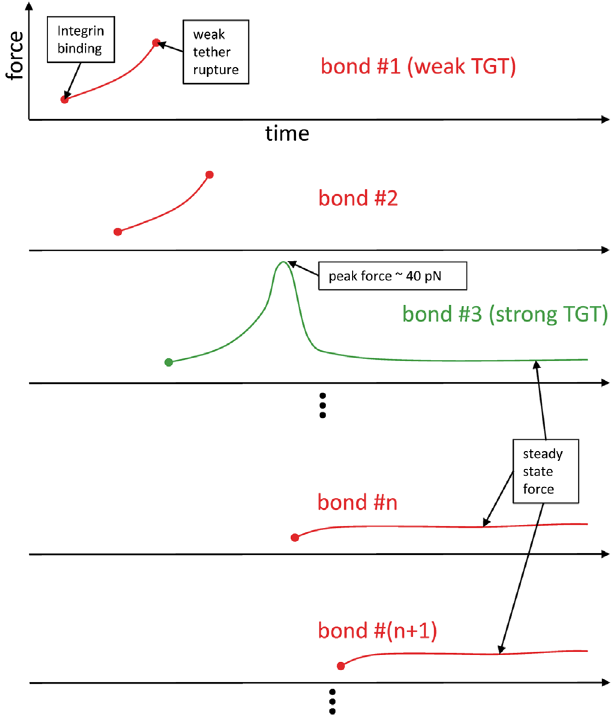
FIG. 7. Proposed time courses of mechanical engagements through single integrin-ligand bonds. A cell grabs a ligand attached to the surface through a weak tether and applies gradually increasing force until the weak tether ruptures. If a strong tether is pulled, the 40 pN threshold force for adhesion is reached, telling the cell that the substrate is rigid enough for adhesion. Then, the force through the bond drops to a low, steady- state value, and subsequent bonds experience only this lower force. The cell no longer needs to apply strong forces because it has already determined that the substrate is rigid